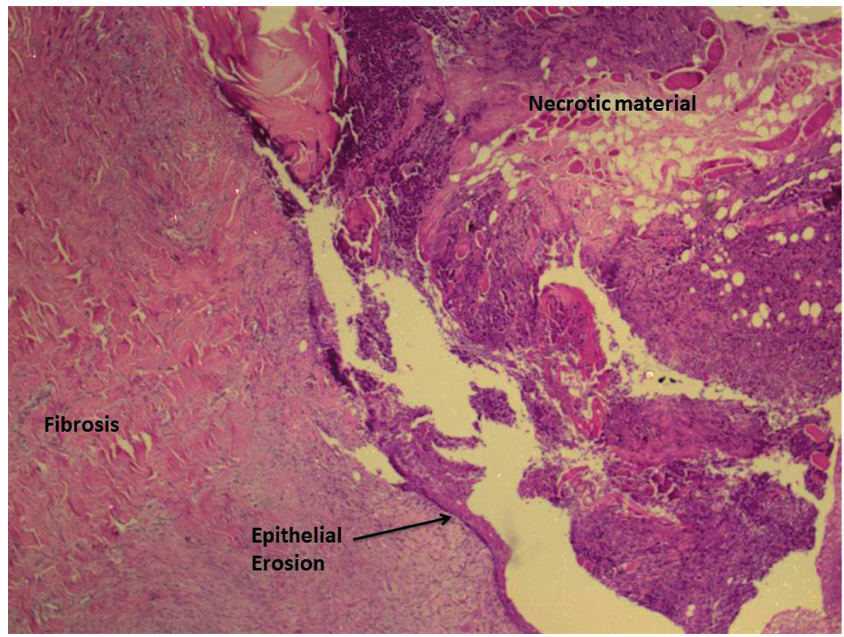
figure 2 - histological aspect of the reconstructed urethra in which dorsal component consisted of a transitional urothelium and ventral component of a stratified scamous epithelium (group 8 weeks, hE x